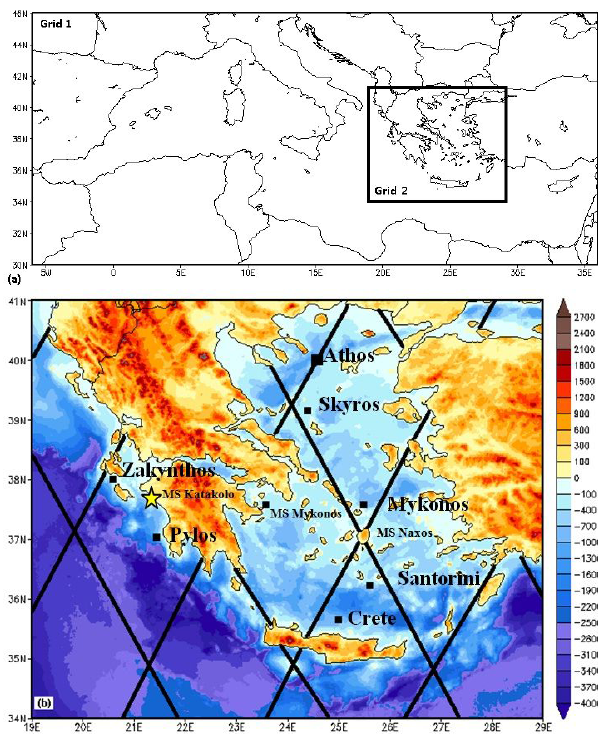
Fig. 1. (a) Extension of the WAM grids. The inner rectangle denotes the position of the finer grid. (b) Bathymetry and orography of the fine grid. The black lines denote the ground tracks of Jason-2 above Greece while the wave buoys used for validation are marked with